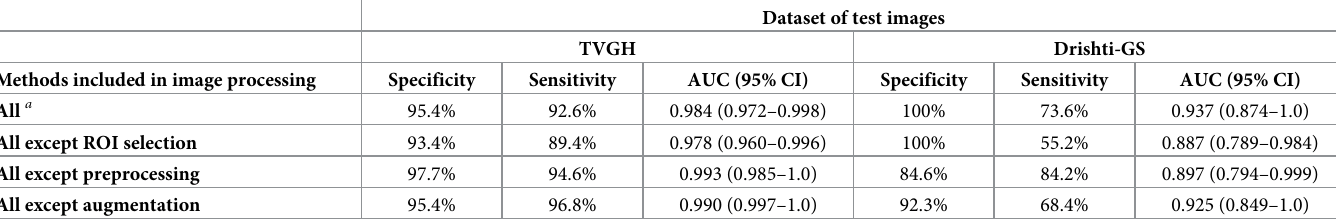
Table 3. Impact of image processing on the performance of the proposed CNN model in identifying glaucomatous discs using a mixed training dataset including training images of Drishti-GS and TVGH